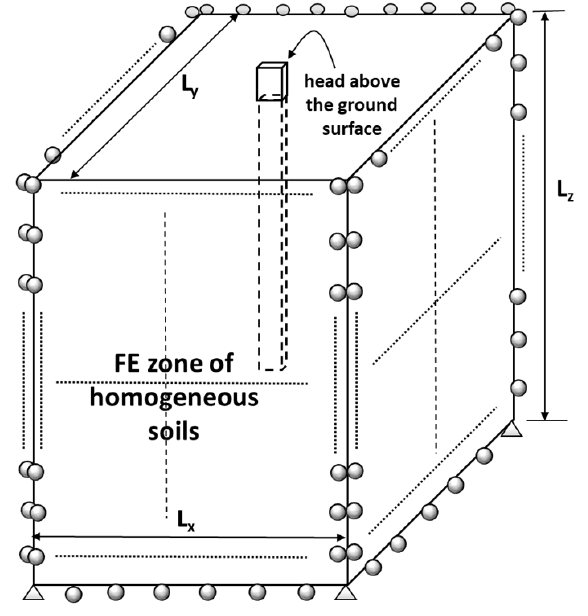
Fig. 2. Geometry and boundaries of FE analysis in this study